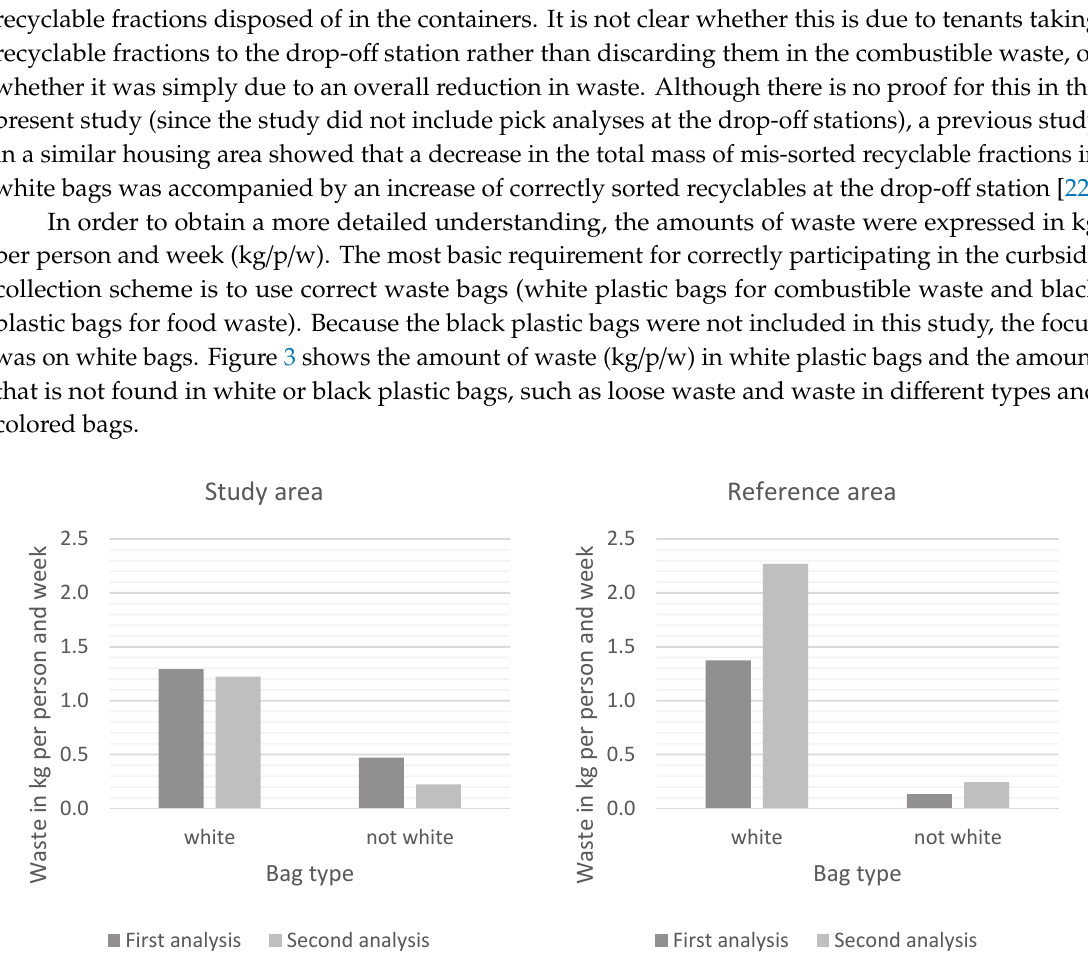
Figure 3. Amount of waste per person and week displayed for the types of bag analyzed in this study. Ideally, there should only be white bags. Any other colored bag or loose waste is incorrectly disposed of according to the local recycling scheme. Black bags, intended for food waste, were not considered in this study.